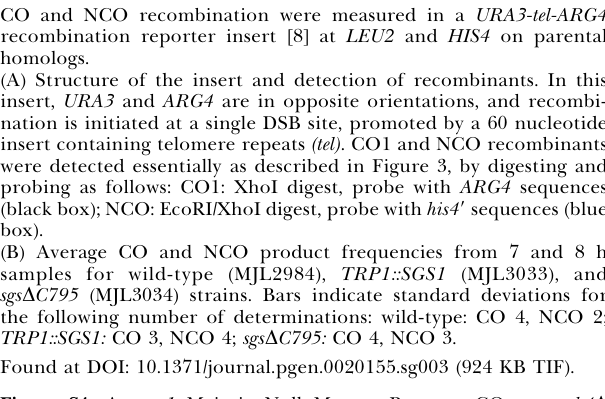
Figure S1. sgs1-mn Is a Meiosis-Specific Null Allele (A) Western blot probed with anti-HA (top panel) to detect 3HA-Sgs1 expressed from the CLB2 promoter, or anti-Tub2 (bottom panel) to detect Tub2 as a loading control. Protein was extracted from a synchronously sporulating culture of MJL3091 at the indicated times. * indicates cross-reacting protein that is present in all samples. (B) Graph of relative 3HA-Sgs1 levels, with 0 h sample levels set at 100%. This corresponds to between 1 and 1.5 times the level of Sgs1 seen in 0 h samples from wild-type cells (unpublished data). Found at DOI: 10.1371/journal.pgen.0020155.sg001 (1.0 MB TIF). Figure S2. Effect of sgs1 D C795 on CO Recombination in SK1 Strains CO recombination was measured as described in Figure 3B. Values reflect averages of 7 and 8 h samples from multiple blots of DNA measurements, 3 cultures; sgs1 D C795, 6 measurements, 3 cultures; sgs1-mn, 5 measurements, two cultures. Found at DOI: 10.1371/journal.pgen.0020155.sg002 (330 KB TIF). Figure S3. sgs1 D C795 Does Not Substantially Alter CO or NCO Recombination in a Second Interval CO and NCO recombination were measured in a URA3-tel-ARG4 recombination reporter insert [8] at LEU2 and HIS4 on parental homologs. (A) Structure of the insert and detection of recombinants. In this insert, URA3 and ARG4 are in opposite orientations, and recombi-